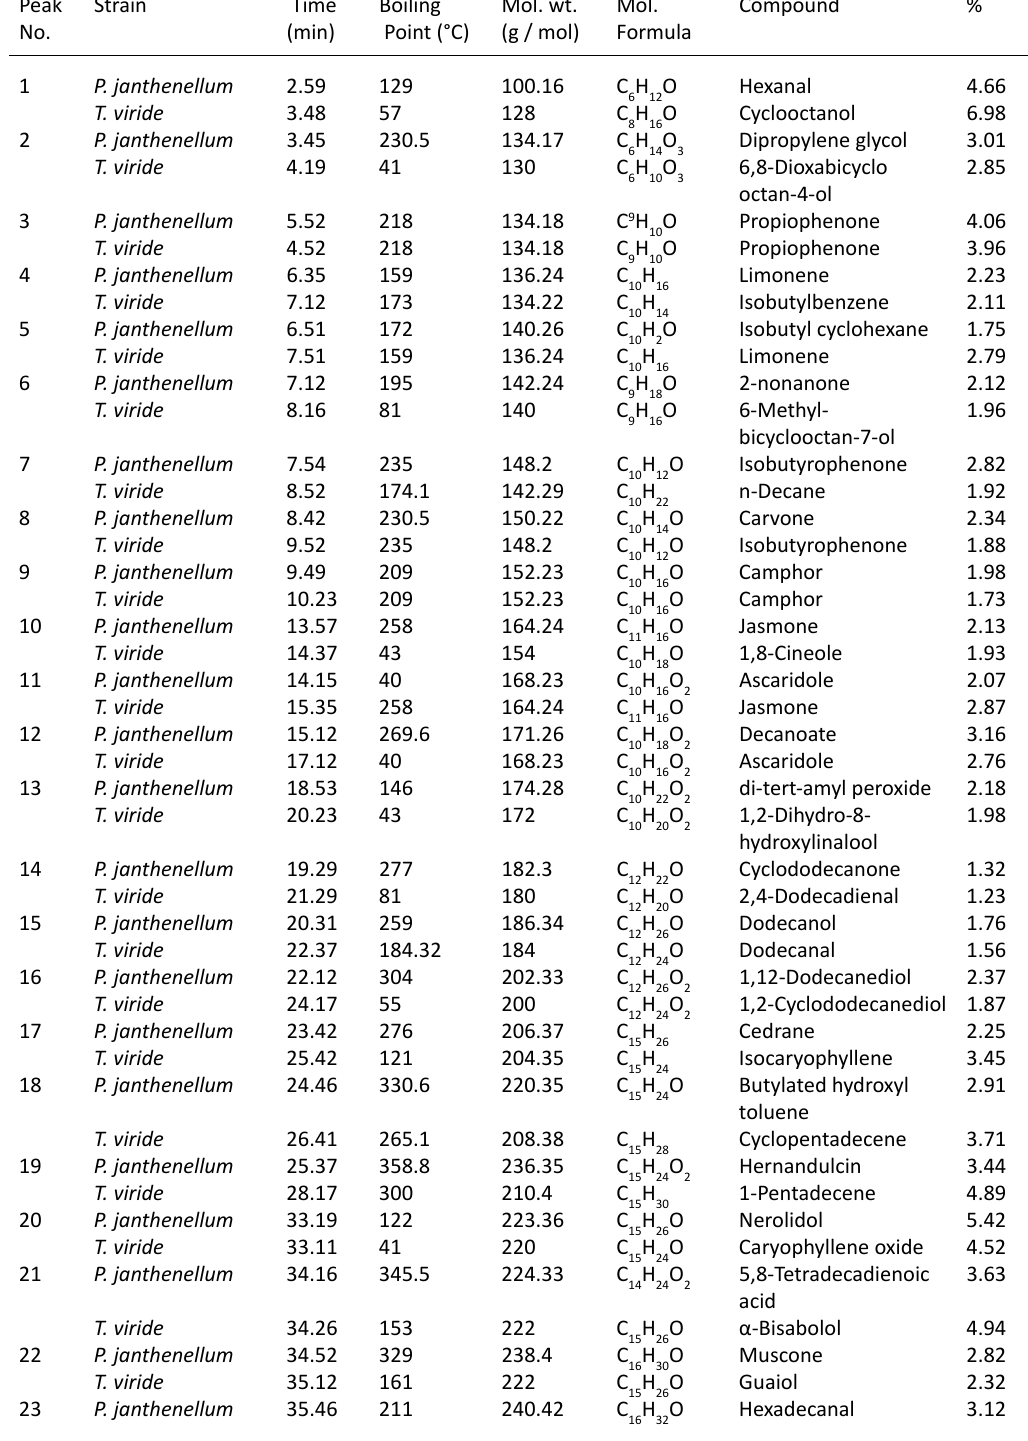
Table 6. GC / MS analysis of the volatile constituents from P. janthenellum and T. viride mycelia Peak Strain Time Boiling Mol. wt. Mol. Compound % No. (min) Point (°C) (g / mol)